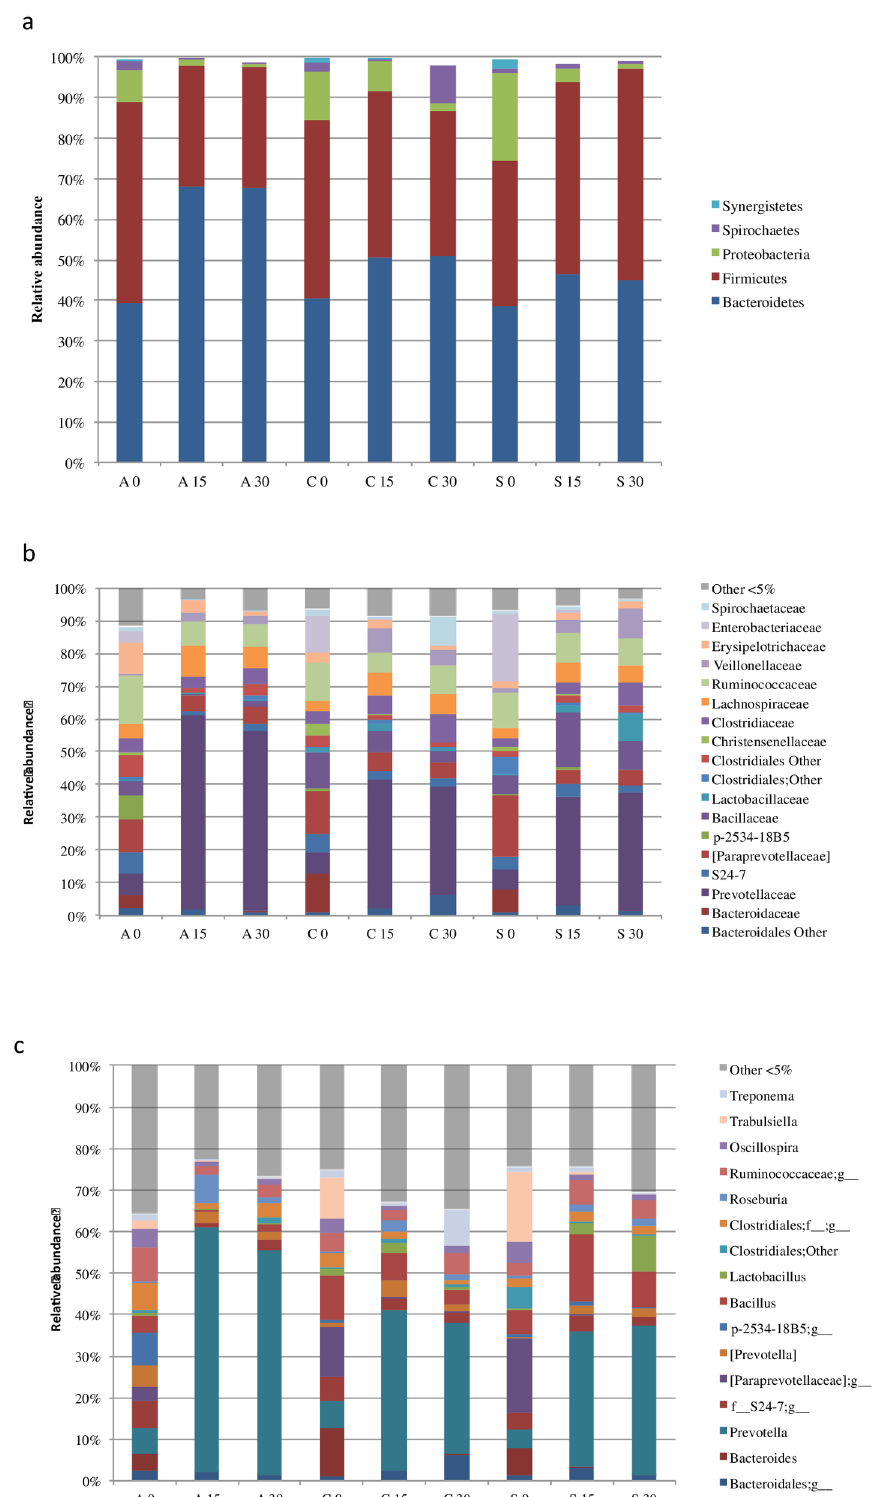
Fig 5. Digestive microbiota from antibiotic (A), control (C) and feed additive (S) treated piglets. The mean relative abundance (%) of OTUs found at phylum (a), family (b) and genus (c) level in faecal samples is presented. X Y means experimental (control-C, feed additive- S, antibiotic-A,) and day group (0, 15 and 30), respectively.